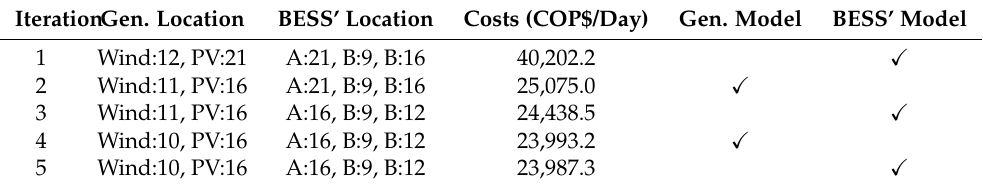
Table 9. Search process for the simultaneous allocation of BESS and renewables in monopolar DC networks using MIC models and recursive programming.